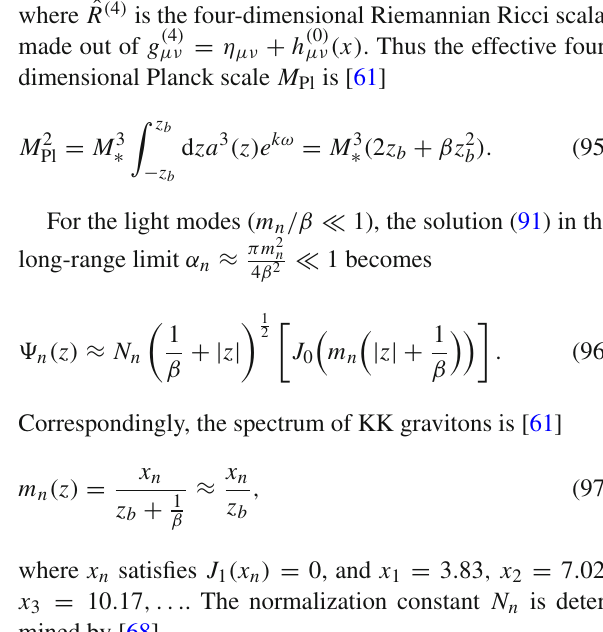
where x n satisfies J 1 ( x n ) = 0, and x 1 = 3 . 83 , x 2 = 7 . 02 , x 3 = 10 . 17 , . . . . The normalization constant N n is deter- mined by